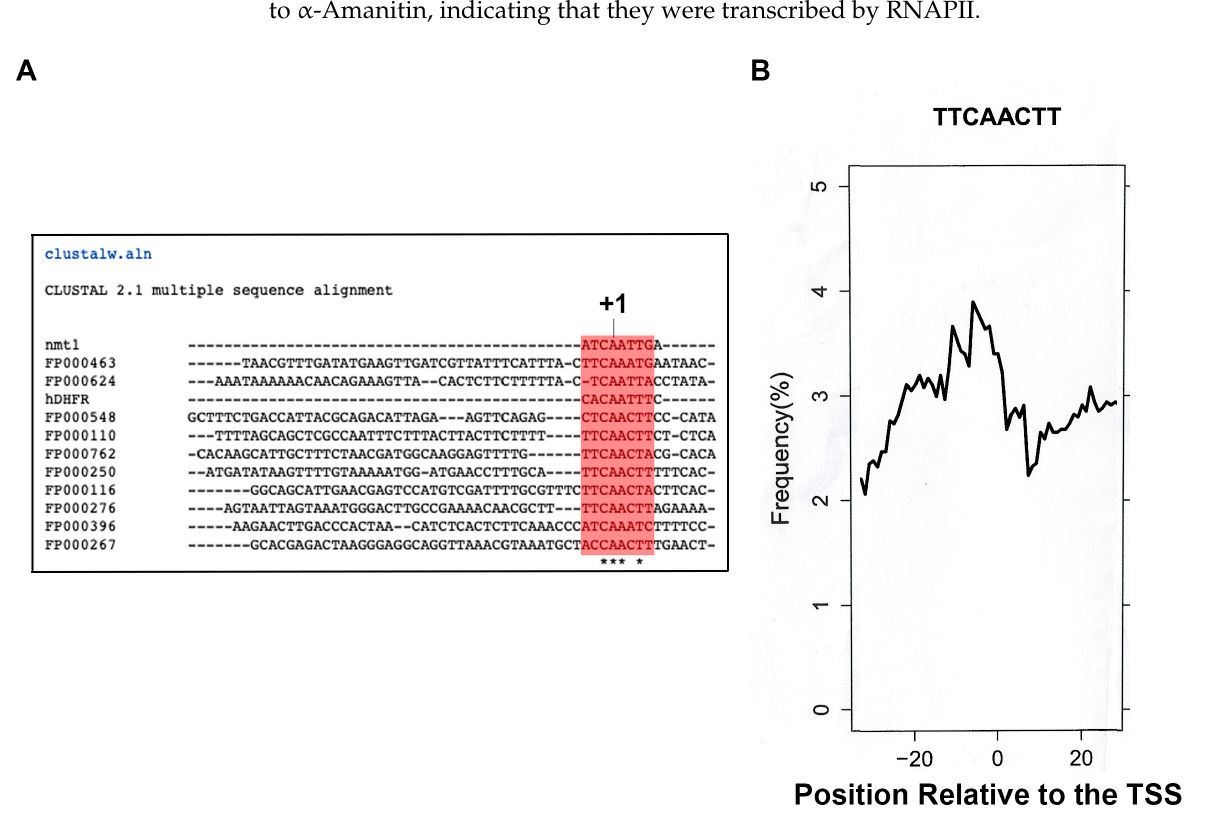
Figure 1. Fission yeast TATA-less promoters contain a highly conserved sequence around the TSS. ( A ) Several fission yeast TATA-less promoters (obtained from the EPD) were aligned with the nmt1 Inr and the human DHFR Inr. The conserved sequence (TTCA + 1ACTT), that represents the Inr, is highlighted in red. The alignment was performed with the ClustalW program (https://www.genome.jp/tools-bin/clustalw, accessed on 23 April 2021). ( B ) Distribution of the TTCAACTT sequence in S. pombe (obtained from the EPD). It can be observed that the exact match to this sequence is contained in approximately 4% of the fission yeast promoters described in S.